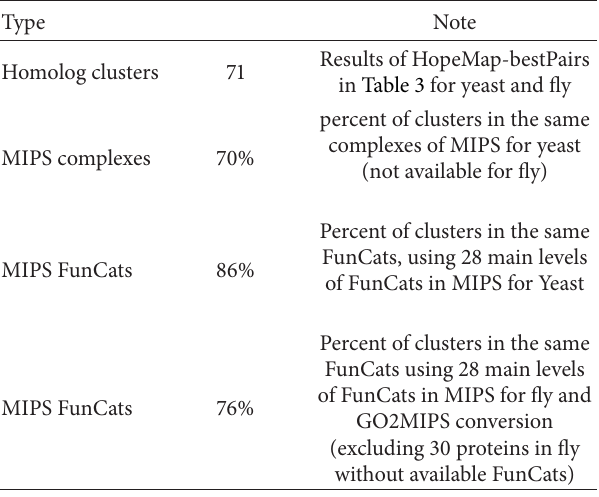
Table 8: Specificity in MIPS for homologues cluster of yeast/fly in HopeMap.